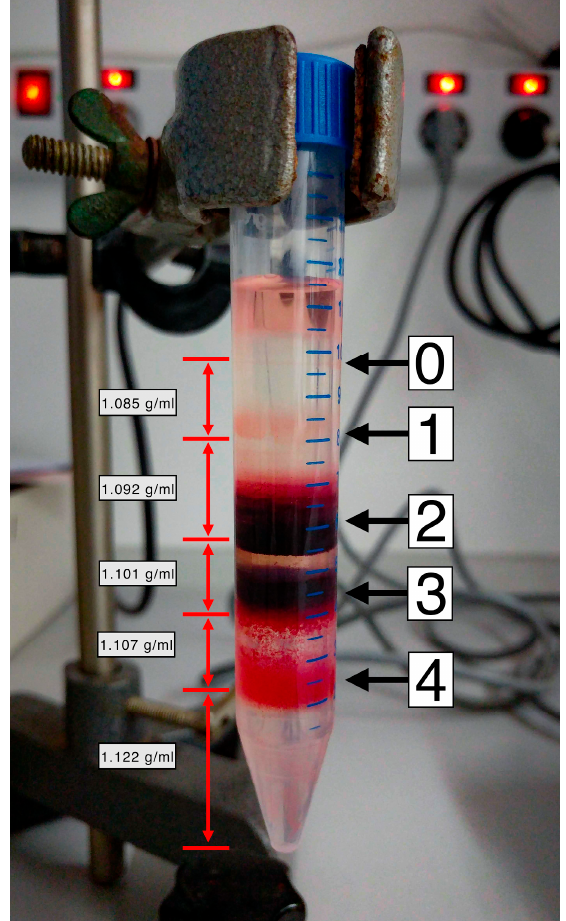
Figure 1. Red blood cells (RBCs) fractionated by Percoll. Four (1–4) different fractions of RBCs of different ages are presented. Fraction #0 for the blood of some volunteers had a negligible amount of RBCs, making it impossible to perform the experiment.